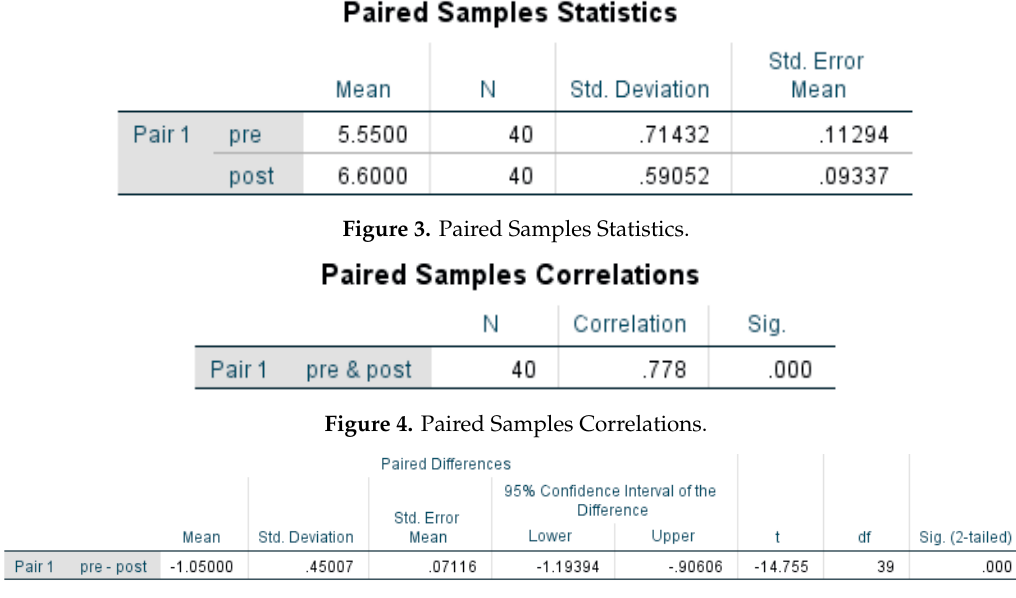
Figure 5. Paired Samples Test.